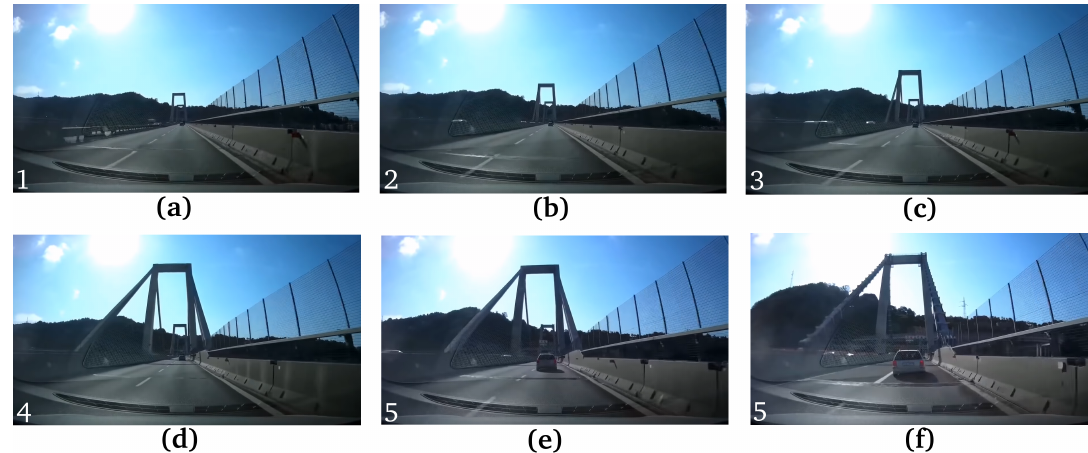
Figure 33. Optical representation of the Morandi bridge, the images were taken from a car crossing the bridge a few days before the collapse. ( a – f ): The connection joints of the “Morandi” bridge.